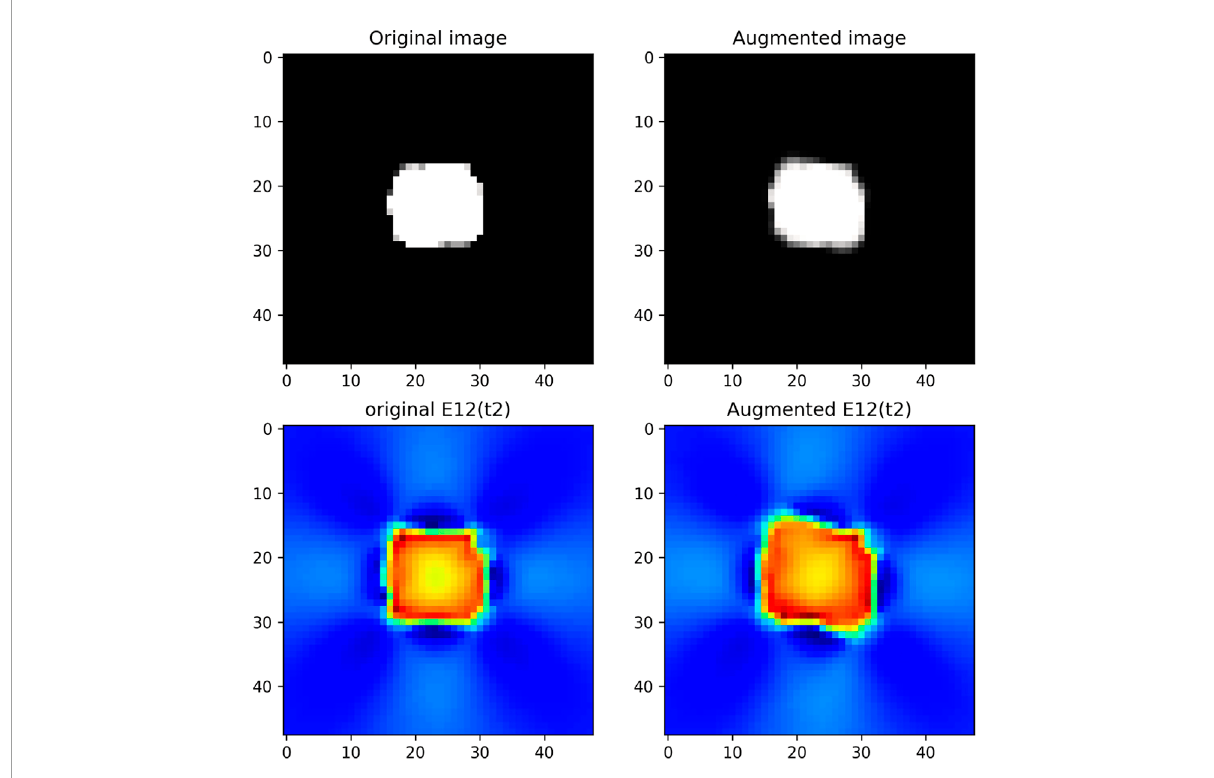
FIGURE 6 Example of augmented multimodal data for digital twin i = 2: on the left, original data; on the right, augmented data; in the first-row, μ □ ; in the second row, the shear strain at time t 2.